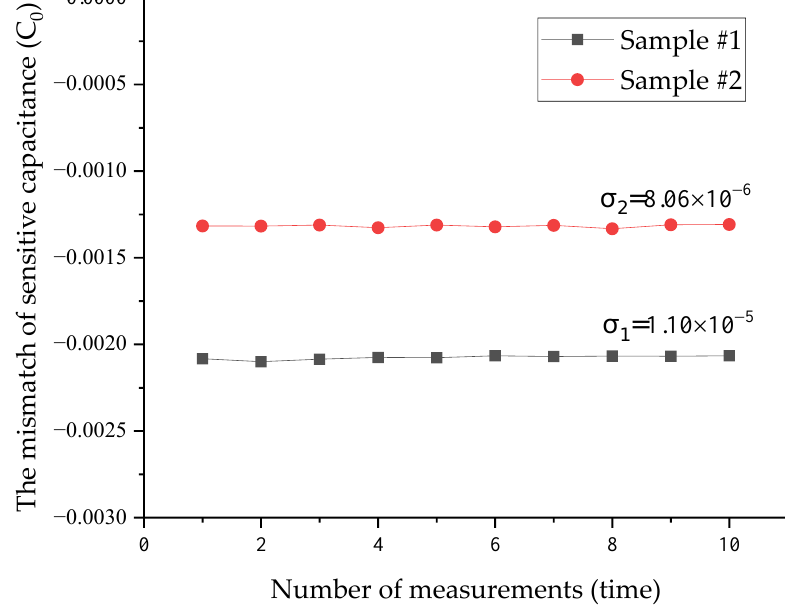
Figure 7. Measurement data of experimental samples.